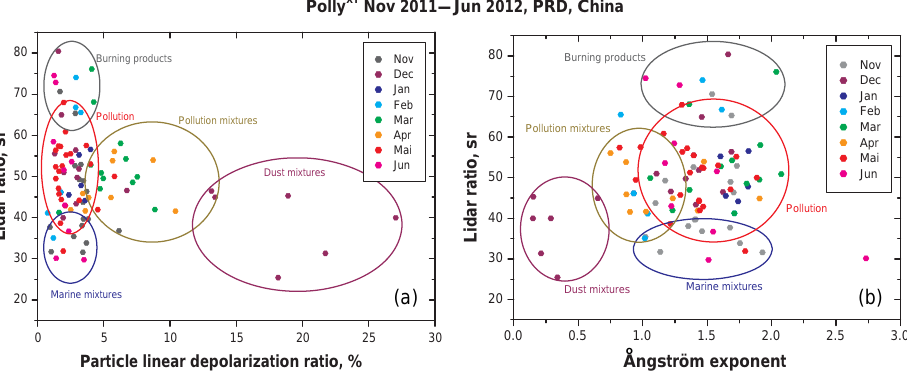
Figure 7. Aerosol classification using lidar ratio at 532nm versus linear particle depolarization (a) and the Ångström exponent related to the linear particle backscatter coefficient at 355–532nm (b) for lofted layers from November 2011 to June 2012. The coloured circles indicate the identified particle mixtures and corresponding measurements. Table 1. Monthly mean values of total AOD and AOD of identified lofted layers derived from lidar extinction profiles. There were 19 profiles used for November, 24 for December, 5 for January, 6 for February, 12 for March, 9 for April, 21 for May, and 10 for June. The total number of profiles is